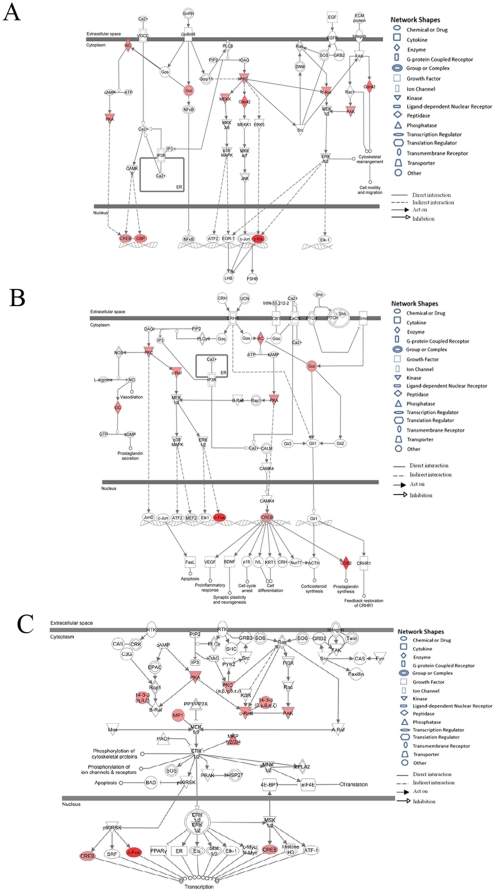
Most significant three canonical pathways of over-expressed genes in GBS patients.(A) GnRH signalling; (B) corticotropin releasing hormone signalling; (C) ERK/MAPK signalling. Red: up-regulated in GBS compared to control. The intensity of the node color indicated the degree of up-regulation. Genes in uncolored notes were not identified as differentially expressed in our experiment and were integrated into the computationally generated networks on the basis of the evidence stored in the IPA knowledge memory indicating a relevance to this pathway.